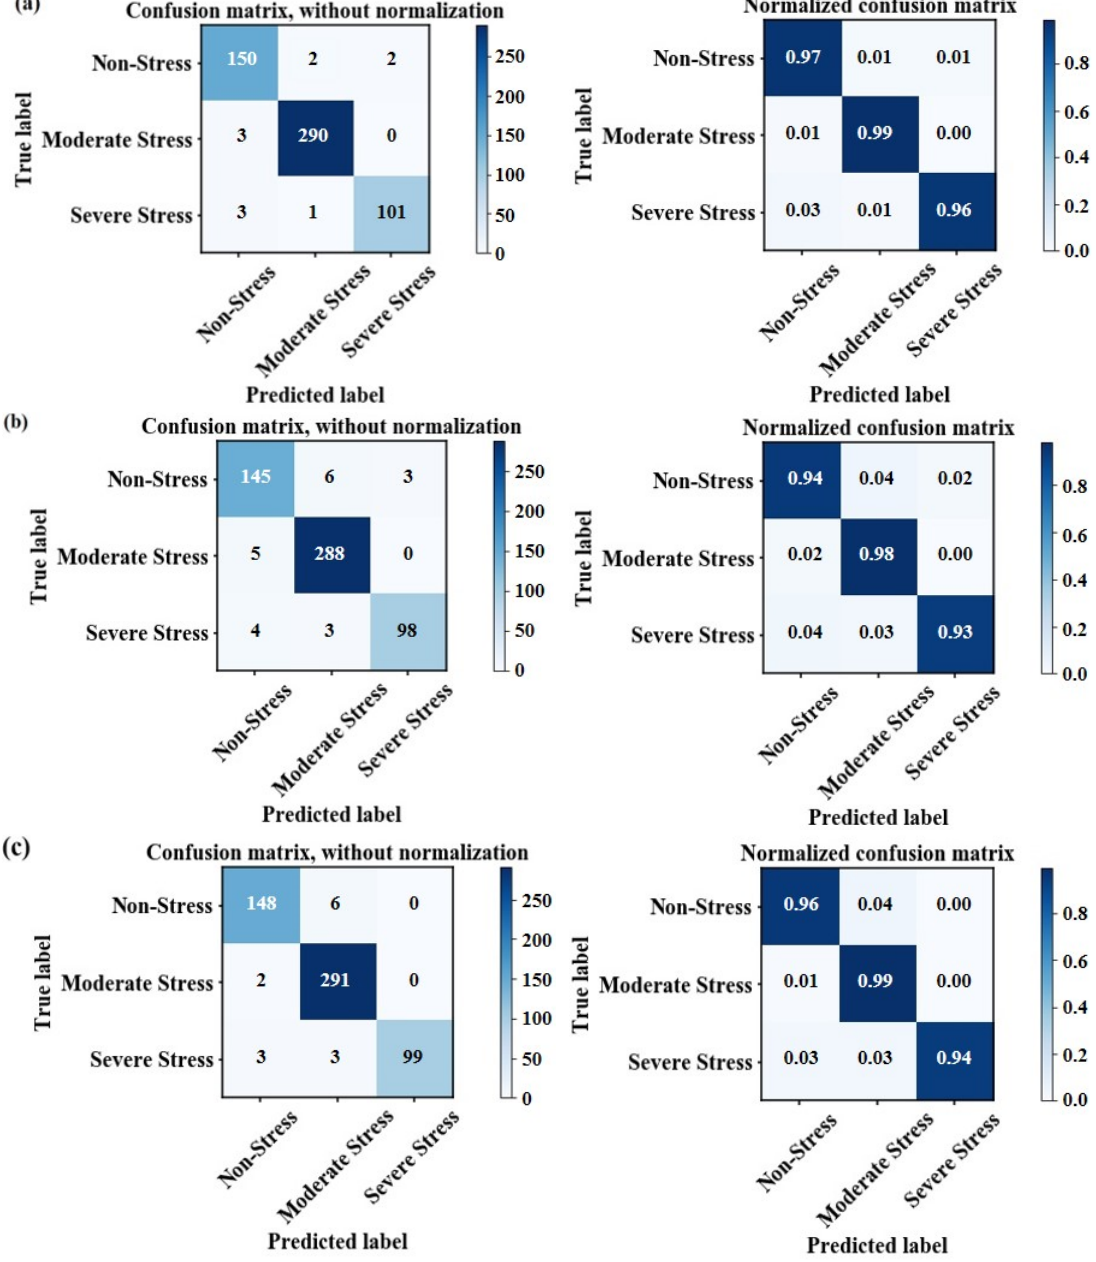
Figure 9. Confusion matrix between estimated and actual stress categories based on ( a ) the ensemble model, ( b ) the RF classifier and ( c ) the GB classifier.